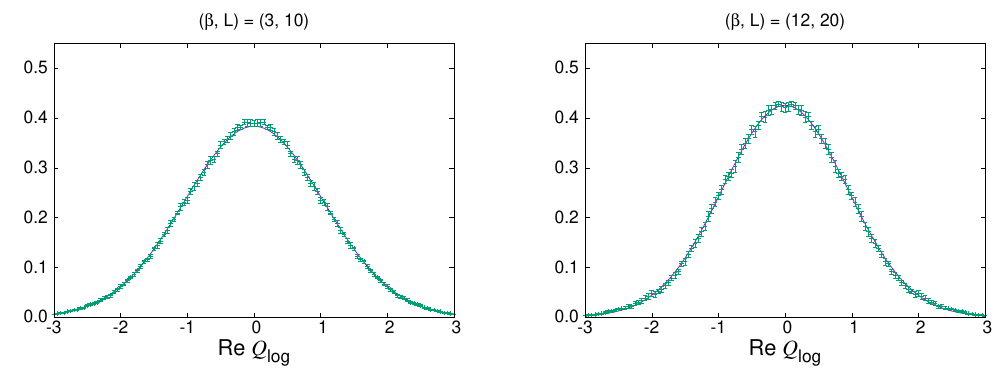
Figure 6 . The topological charge distribution for (cid:18) = 0 obtained by the CLM for the punctured model using the log de(cid:12)nition Q log is plotted for ( (cid:12); L ) = (3 ; 10) (Left) and ( (cid:12); L ) = (12 ; 20) (Right). The solid lines represent the exact results obtained by evaluating (5.4) using the partition function